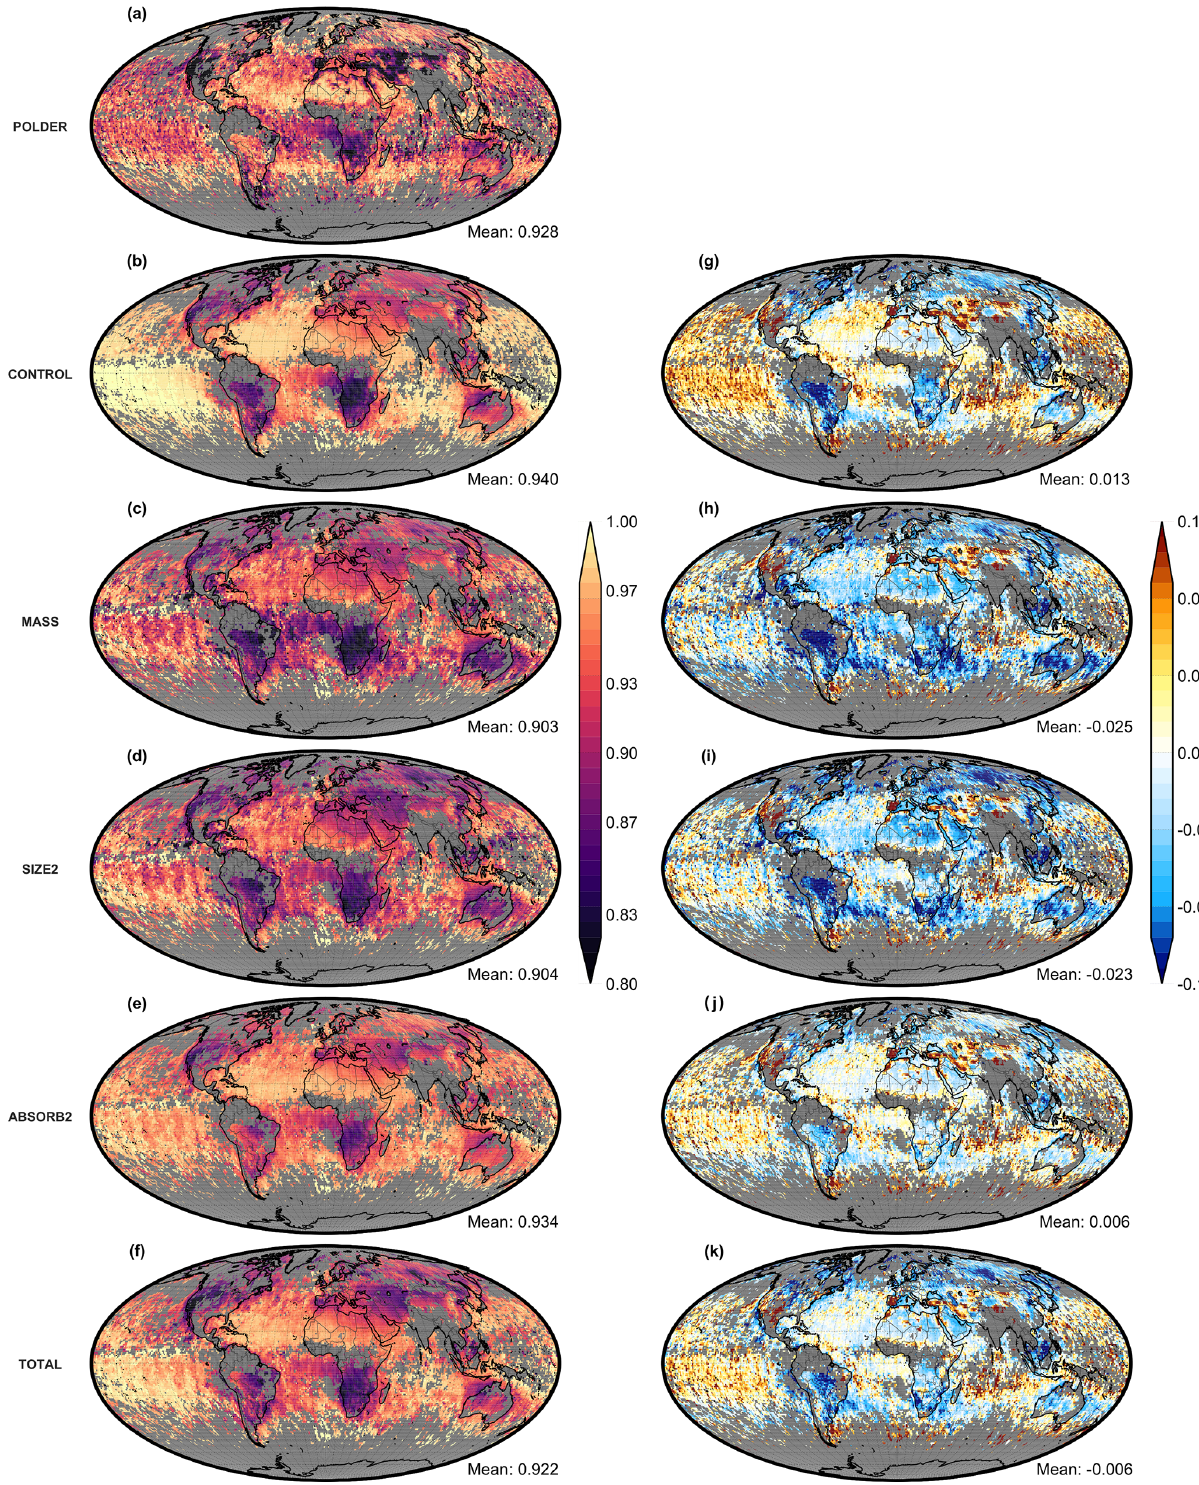
Figure 10. Similar to Fig. 5 but for single scattering albedo at